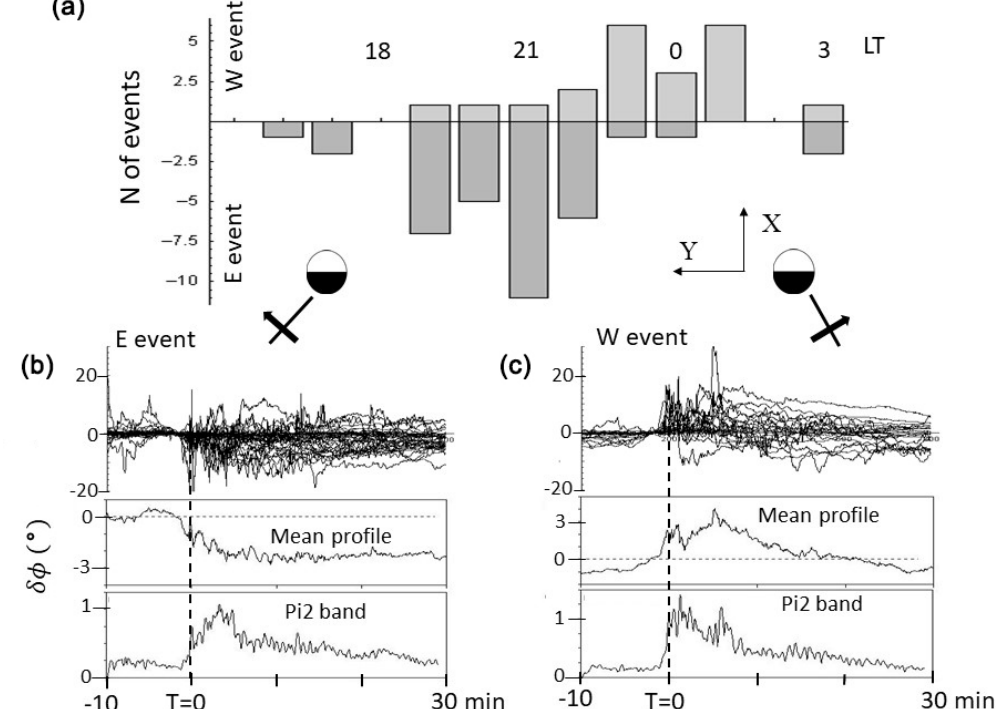
Figure 1. (a) Local time distribution of the W event and E event (see below). (b, c) Epoch superposition of field line deflections in degrees for GOES-5 and GOES-6. Those events with eastward deflections (clockwise rotation, azimuth angle decreased) at T = 0 shown (b) (E event) and those with westward deflections (counterclockwise rotation, azimuth angle increase) at T = 0 are (c) (W event). T = 0 marked by vertical dotted lines corresponds to the first peak of the Pi2 waveform. Amplitudes at the onset ( T = 0) were subtracted from the original data to adjust the pre-onset level. Plots covered 40min from T − 10 to T + 30min. The mean value of the epoch plot and mean value of band-passed (6–20mHz: Pi2 band) amplitudes are also shown. The field line rotations projected to the equatorial plane are illustrated for the E event and W event in the figure (viewed from north of the equatorial